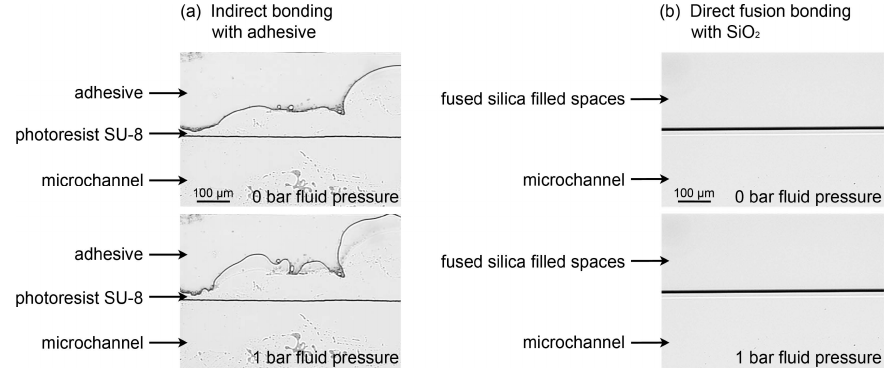
Figure 5. Channels and channel walls of adhesive- and direct fusion-bonded chips. ( a ) The adhesive-based bonded chips consist of two glass substrates with SU-8 spacer and adhesive PD 955 PY for bonding. ( b ) The direct fusion-bonded chips are directly fused glass substrates. Water was introduced and images were taken at a pressure of 0 bar and 1 bar.